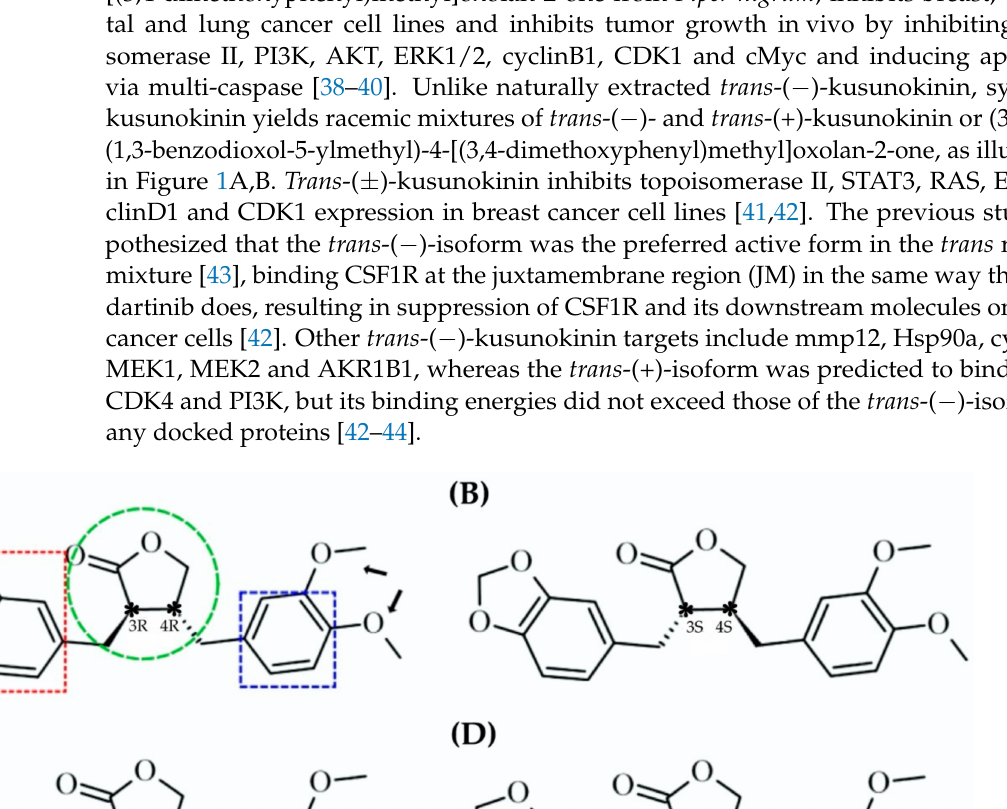
Figure 1. Enantiomeric forms of kusunokinin: ( A ) trans -( ( C ) cis -( )-isomer; ( D ) cis -(+)-isomer. The green circle, red box, blue box and black arrows represented − γ -Butyrolactone, formaldehyde ethylene acetal, benzene ring and methoxy group, respectively. The absolute configuration of both chiral carbons was also addressed. The star sign (*) represented chiral carbon atoms of each kusunokinin